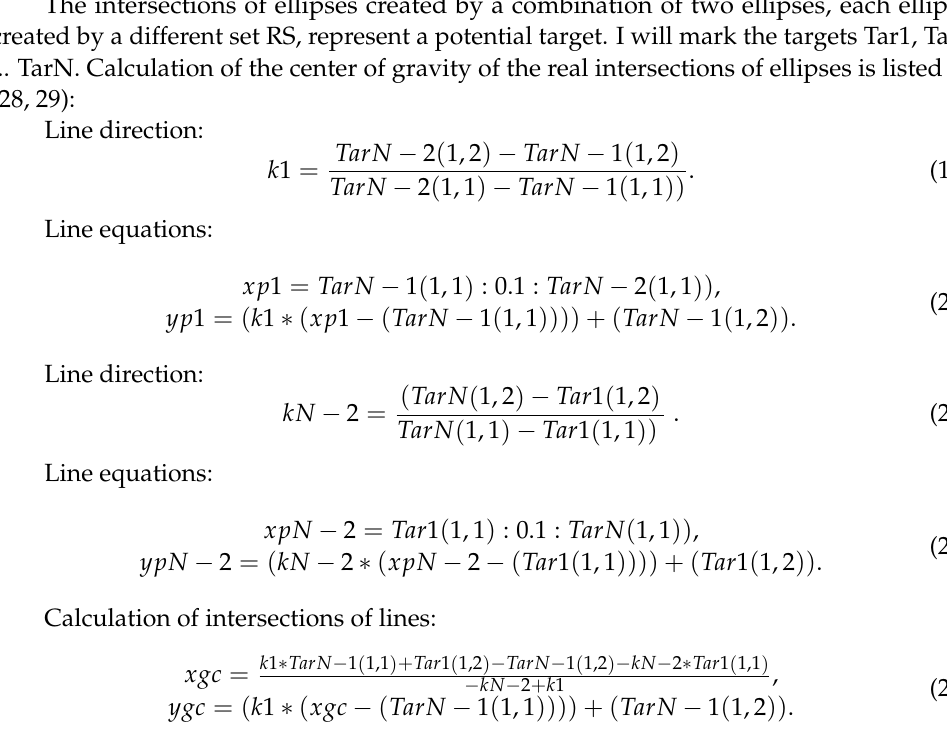
Calculation of the Center of Gravity of the Real Intersections of